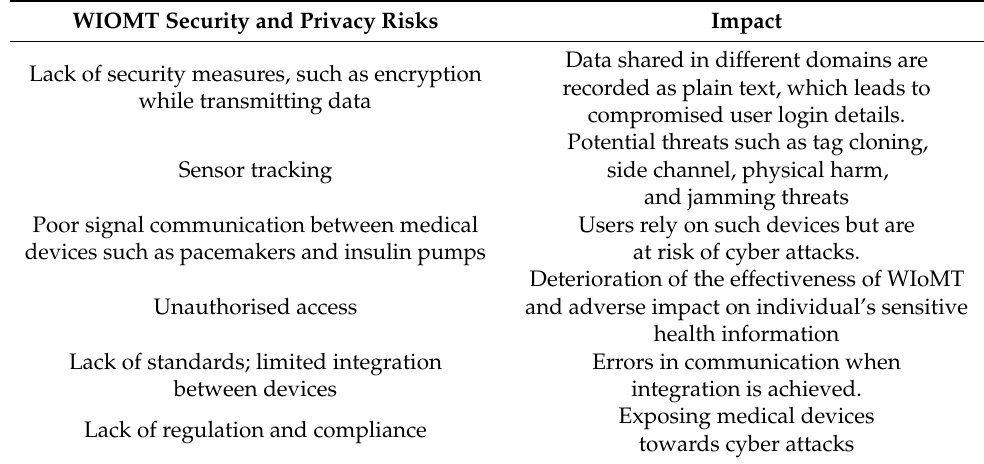
Table 2. Impact of security and privacy